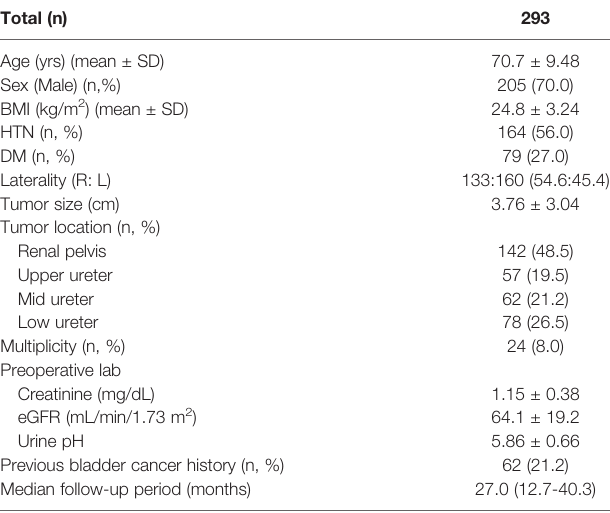
TABLE 1 | Baseline